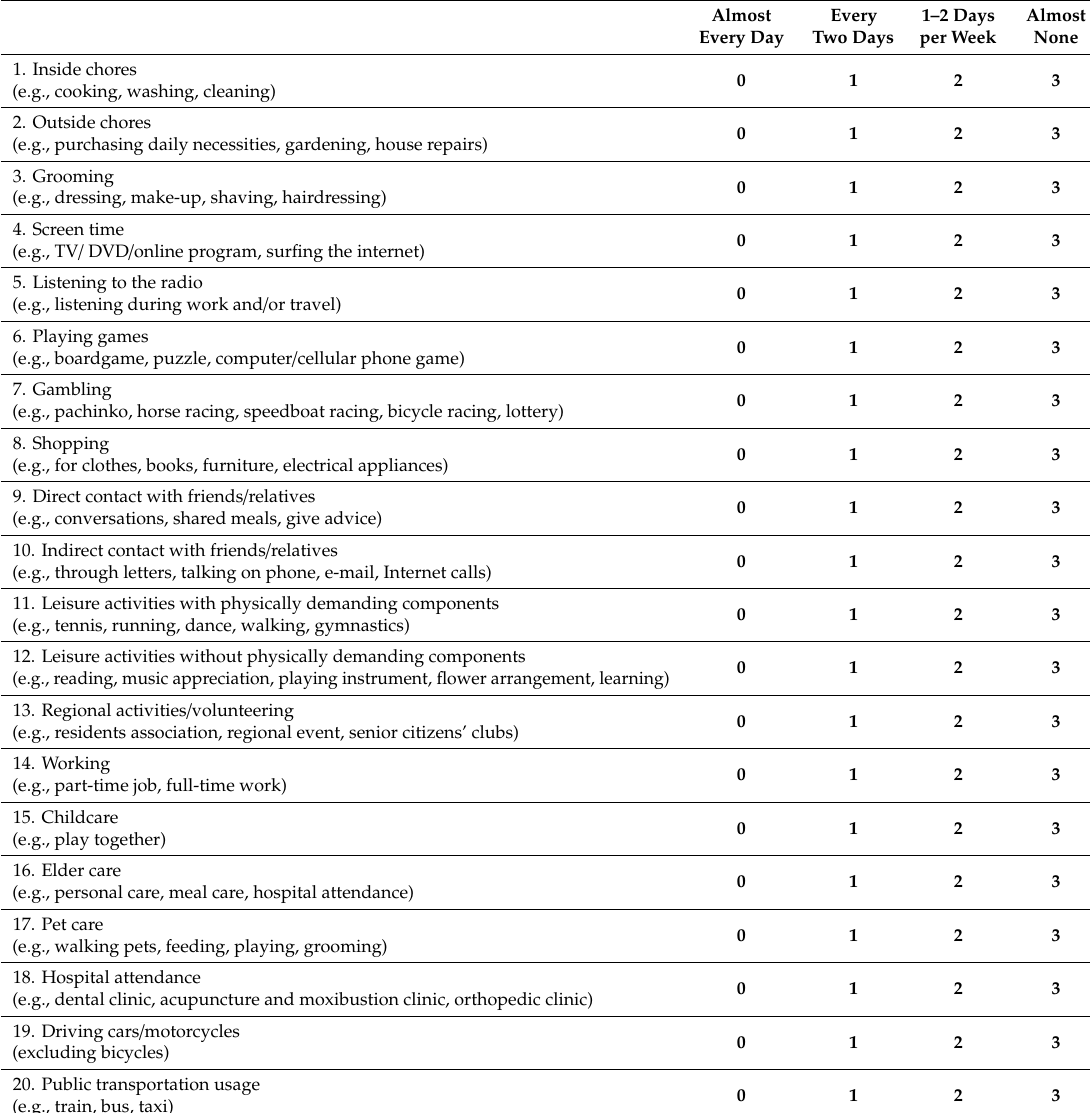
Table A1. Activity Diversity